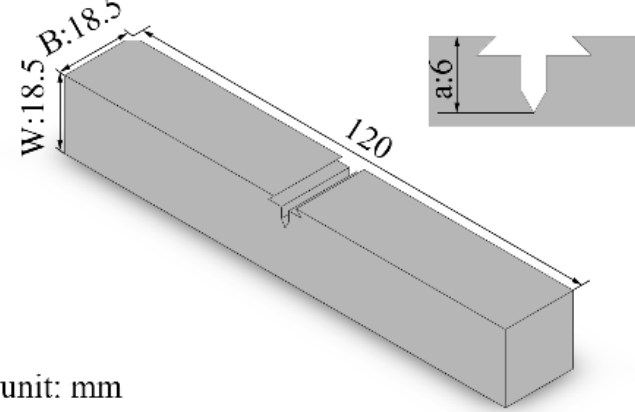
Figure 3. Description of prepared notch form of CTOD fracture toughness specimen (W: wall thickness of the steel pipe; a: depth of prepared notch).